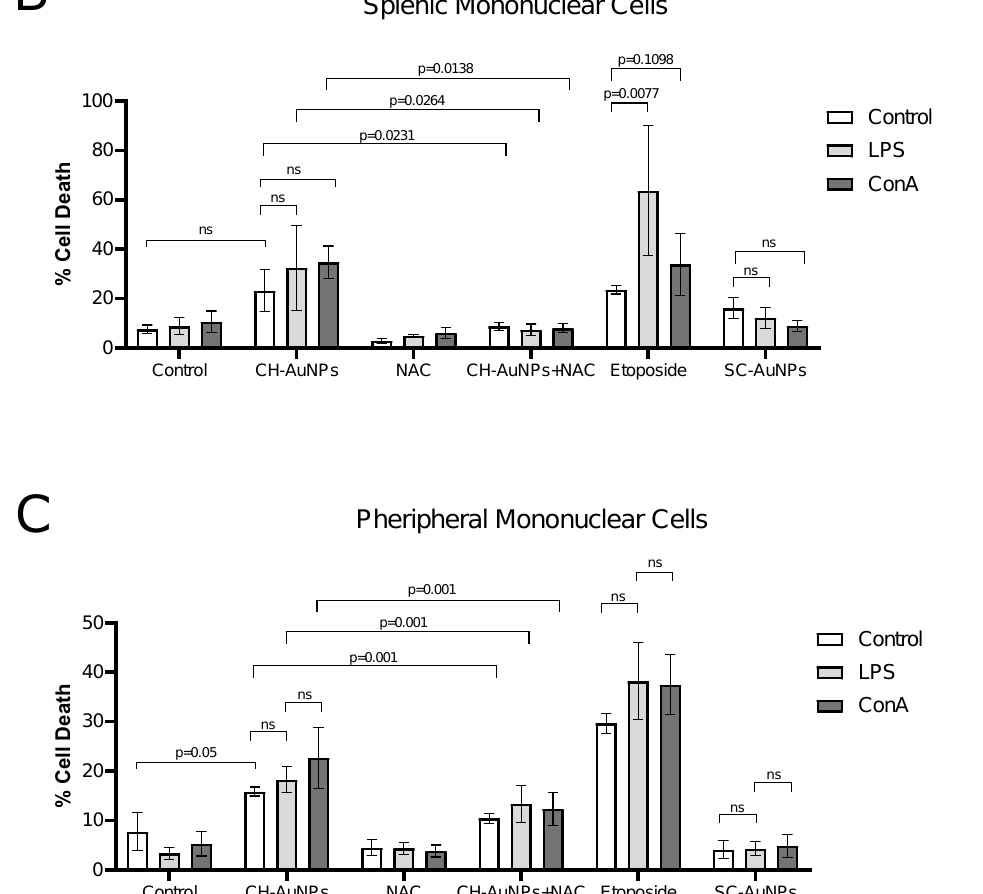
Figure 6. Cell-death analysis of CH-AuNPs, SC-AuNPs, and etoposide in BMCs, splenic mononuclear cells, and PBMCs under proliferative stimuli. Cell-death quantification of ( A ) BMC, ( B ) splenic mononuclear cells, and ( C ) PBMCs treated with CH-AuNPs (125 µ M), SC-AuNPs (125 µ M), and etoposide (100 mM) for 24 h, using lipopolysaccharide (LPS) and concanavalin A (ConA) for stimulation, and NAC as a ROS inhibitor. The results are presented as mean deviation of three different individuals. ns = not significant.